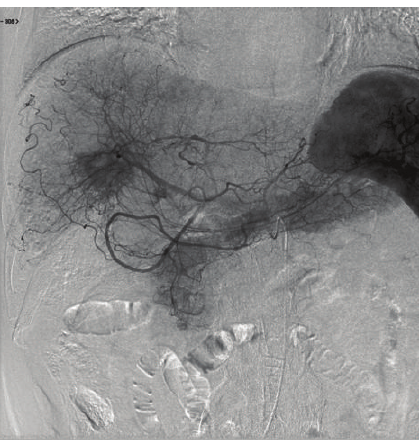
Figure 2: Radiological study of intervention for hepatic inflammatory pseudotumor. Positive staining of nodules (arrows) is visible in segmental 6. The arrowhead denotes tumor